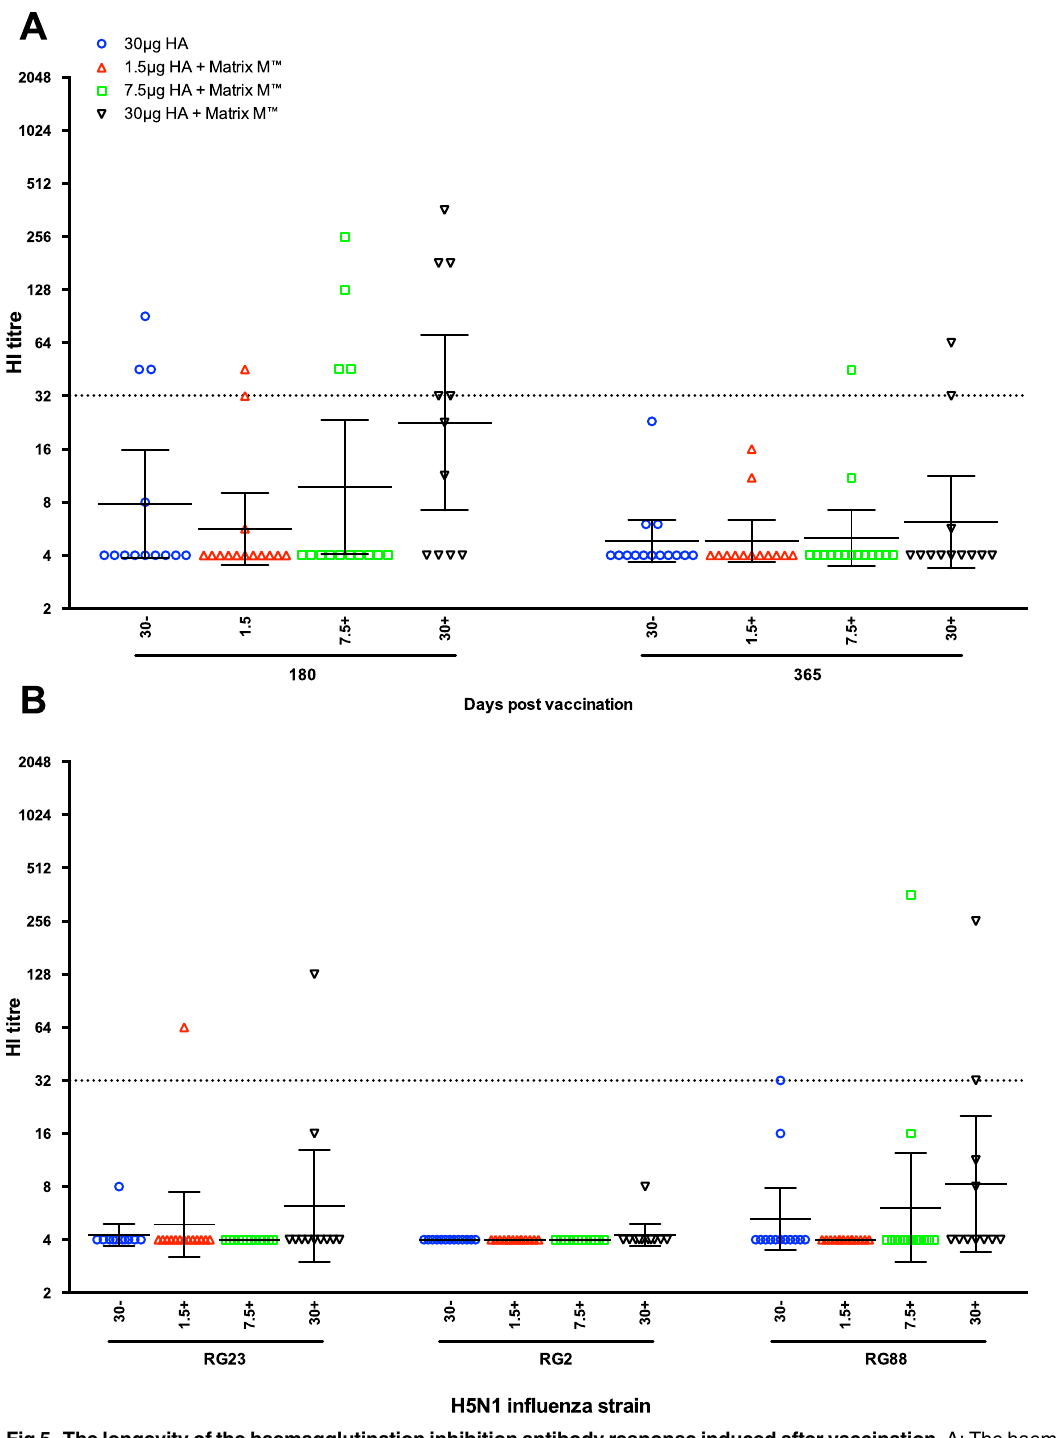
Fig 5. The longevity of the haemagglutination inhibition antibody response induced after vaccination. A: The haemagglutination inhibition (HI) response against the homologous vaccine strain A/Vietnam/1194/2004 (NIBRG-14) at 180 and 365 days after vaccination. B: The cross-H5 clade HI response to A/turkey/Turkey/1/2005 (NIBRG-23), A/Indonesia/5/2005 (RG2) and A/Cambodia/R0405050/2007 (NIBRG-88) at 180 days post-vaccination. Subjects were vaccinated with two doses (21 ± 1 days apart) of inactivated virosomal H5N1 vaccine alone (30 μ g HA, blue) or 1.5 (red), 7.5 (green) or 30 μ g HA (black) adjuvanted with Matrix-M (50 μ g). The HI titres were measured by the modified HI test using horse erythrocytes. Each symbol represents the geometric HI titre for one individual participant, with geometric mean titres for the group and 95% confidence interval presented. The dotted line shows the protective HI titre of